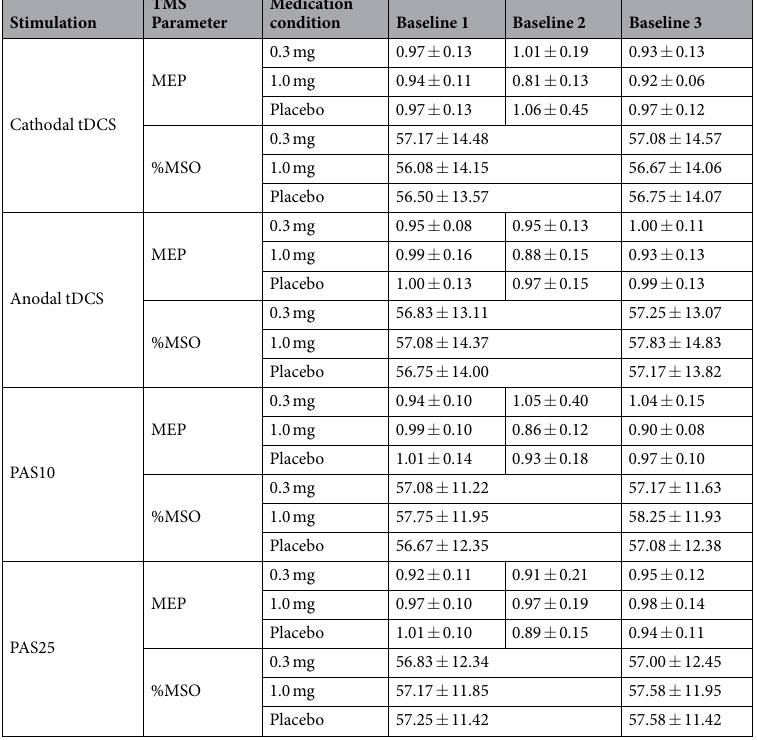
Table 1. MEP amplitudes and stimulation intensity before and after varenicline administration. Shown are the mean MEP amplitudes ± S.D. and stimulation intensity (percentage of maximum stimulator output, %MSO) means ± S.D. of baselines 1, 2 and 3. The intensity of TMS was adjusted to elicit MEPs with peak-to-peak amplitude of ~1 mV (baseline 1). A second baseline (baseline 2) was recorded three hours after varenicline or placebo intake to determine the impact of the drug on cortical excitability and adjusted if necessary (baseline 3). RM-ANOVAs revealed no significant differences between %MSO values and MEP amplitudes.